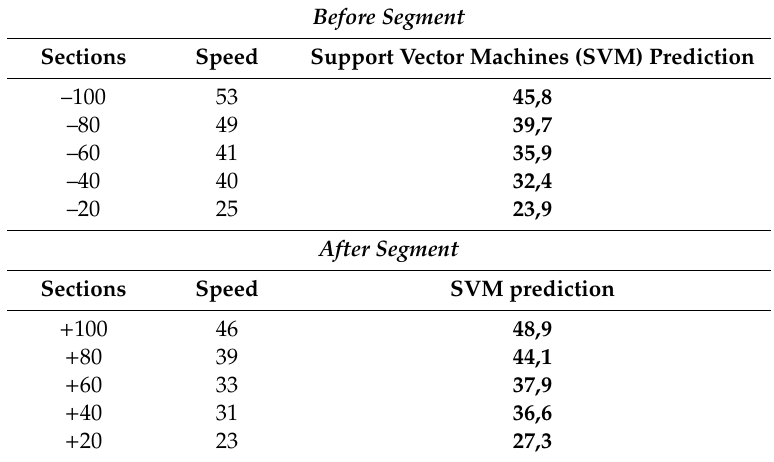
Table 4. Prediction of speed before and after segment—cross-validation.